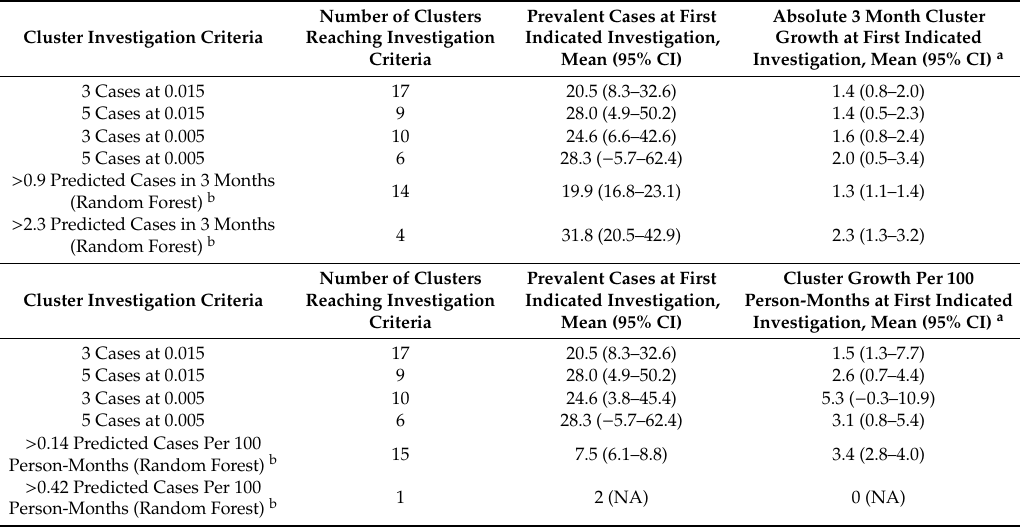
Table 6. Comparison of investigation criteria by cluster size and growth at first indicated investigation, Washington State